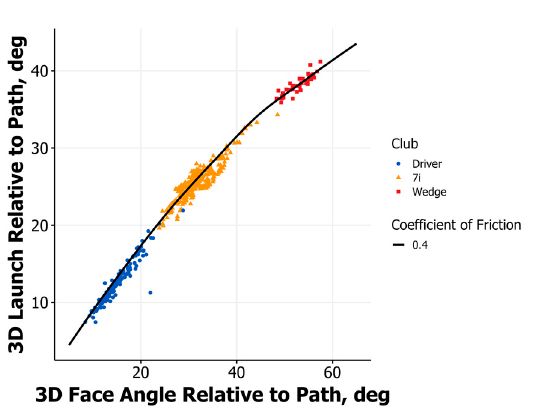
Figure 4. Launch angle relative to club path vs. face normal relative to club